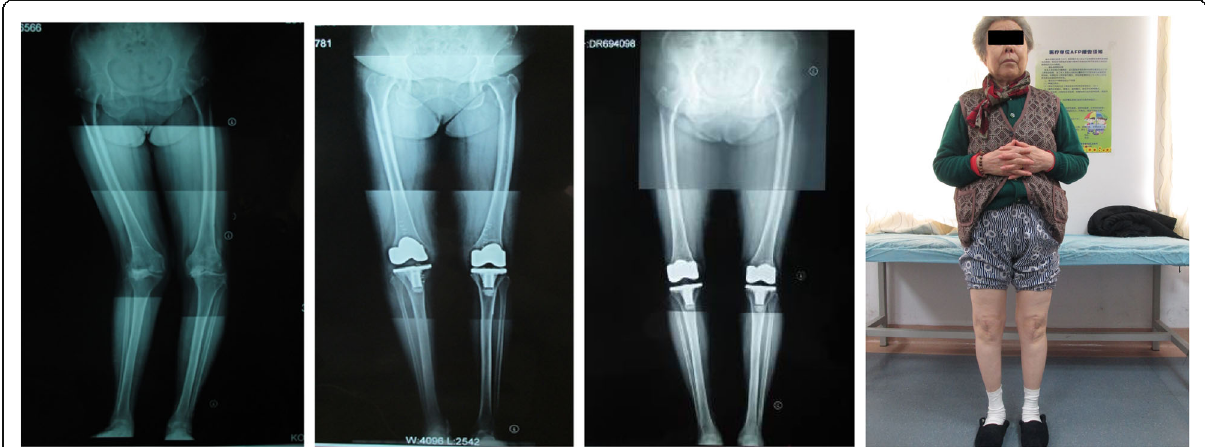
Fig. 6 A seventy-three years old female with right severe knee valgus deformity, 7 years after surgery. Conponents were well-fixed without loosening, and no radiolucent line was